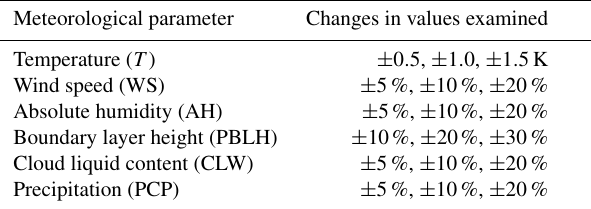
Table 1. Meteorological perturbations imposed in this study. Meteorological parameter Changes in values